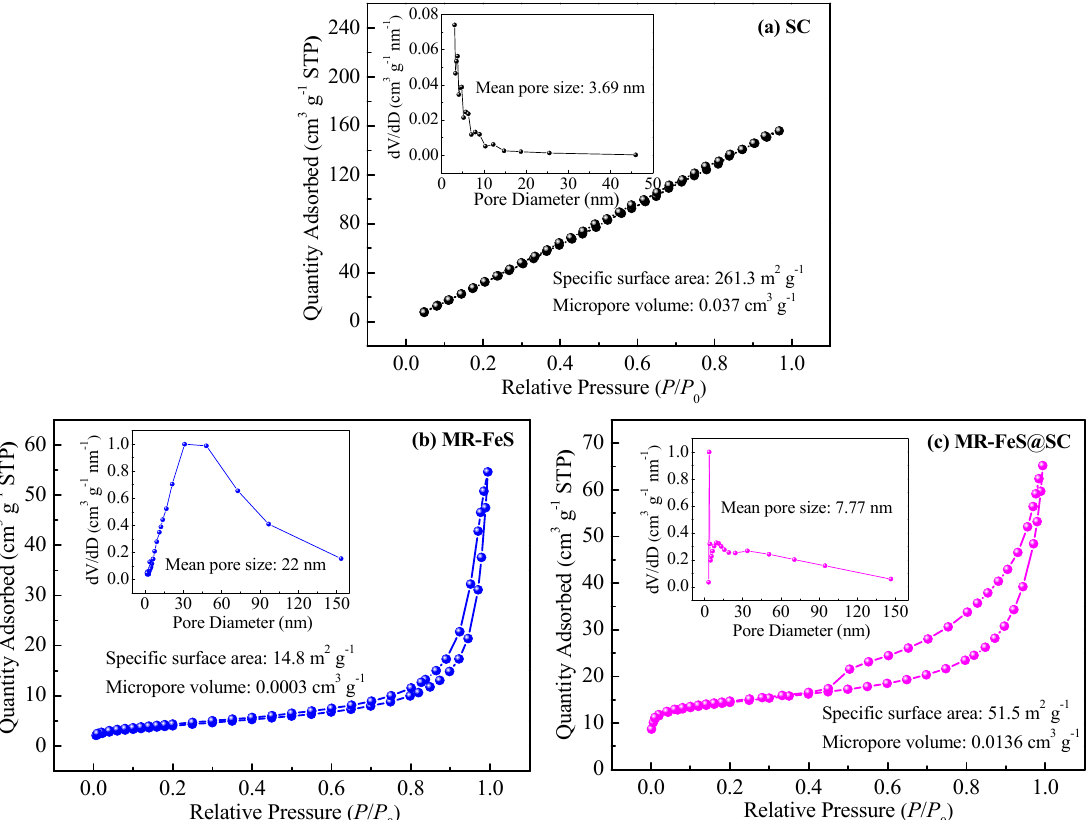
Figure 4. N 2 adsorption – desorption isotherms and pore distributions of ( a ) SC, ( b ) MR – FeS, and ( c ) MR – FeS@SC.